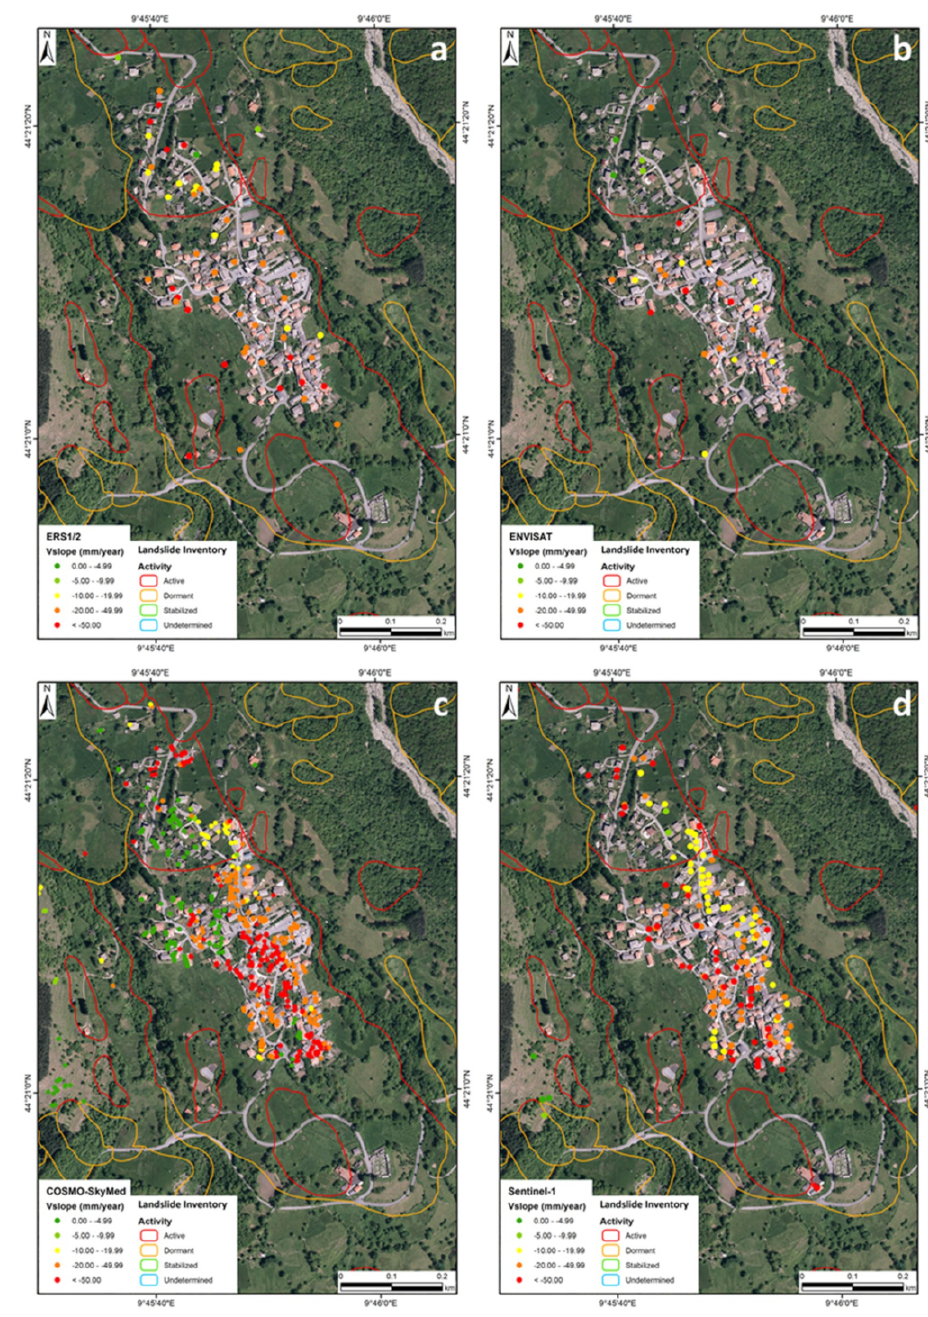
Figure 5. ERS1 / 2 ( a ), ENVISAT ( b ), COSMO-SkyMed ( c ) and Sentinel-1 ( d ) deformation map of velocity along the maximum slope for